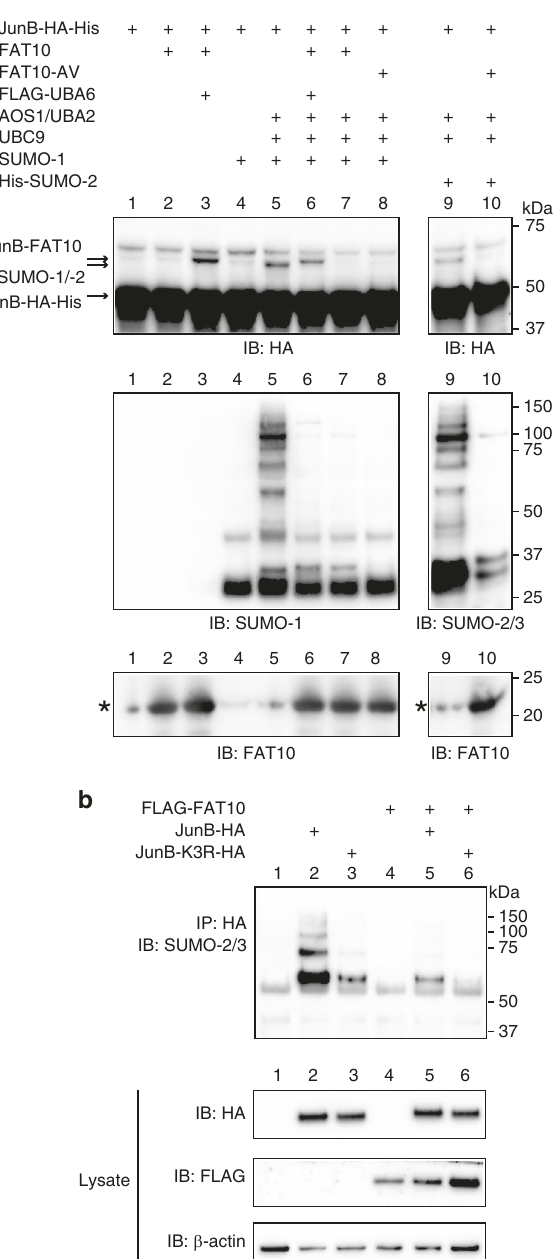
Fig. 2 JunB SUMOylation is diminished in the presence of